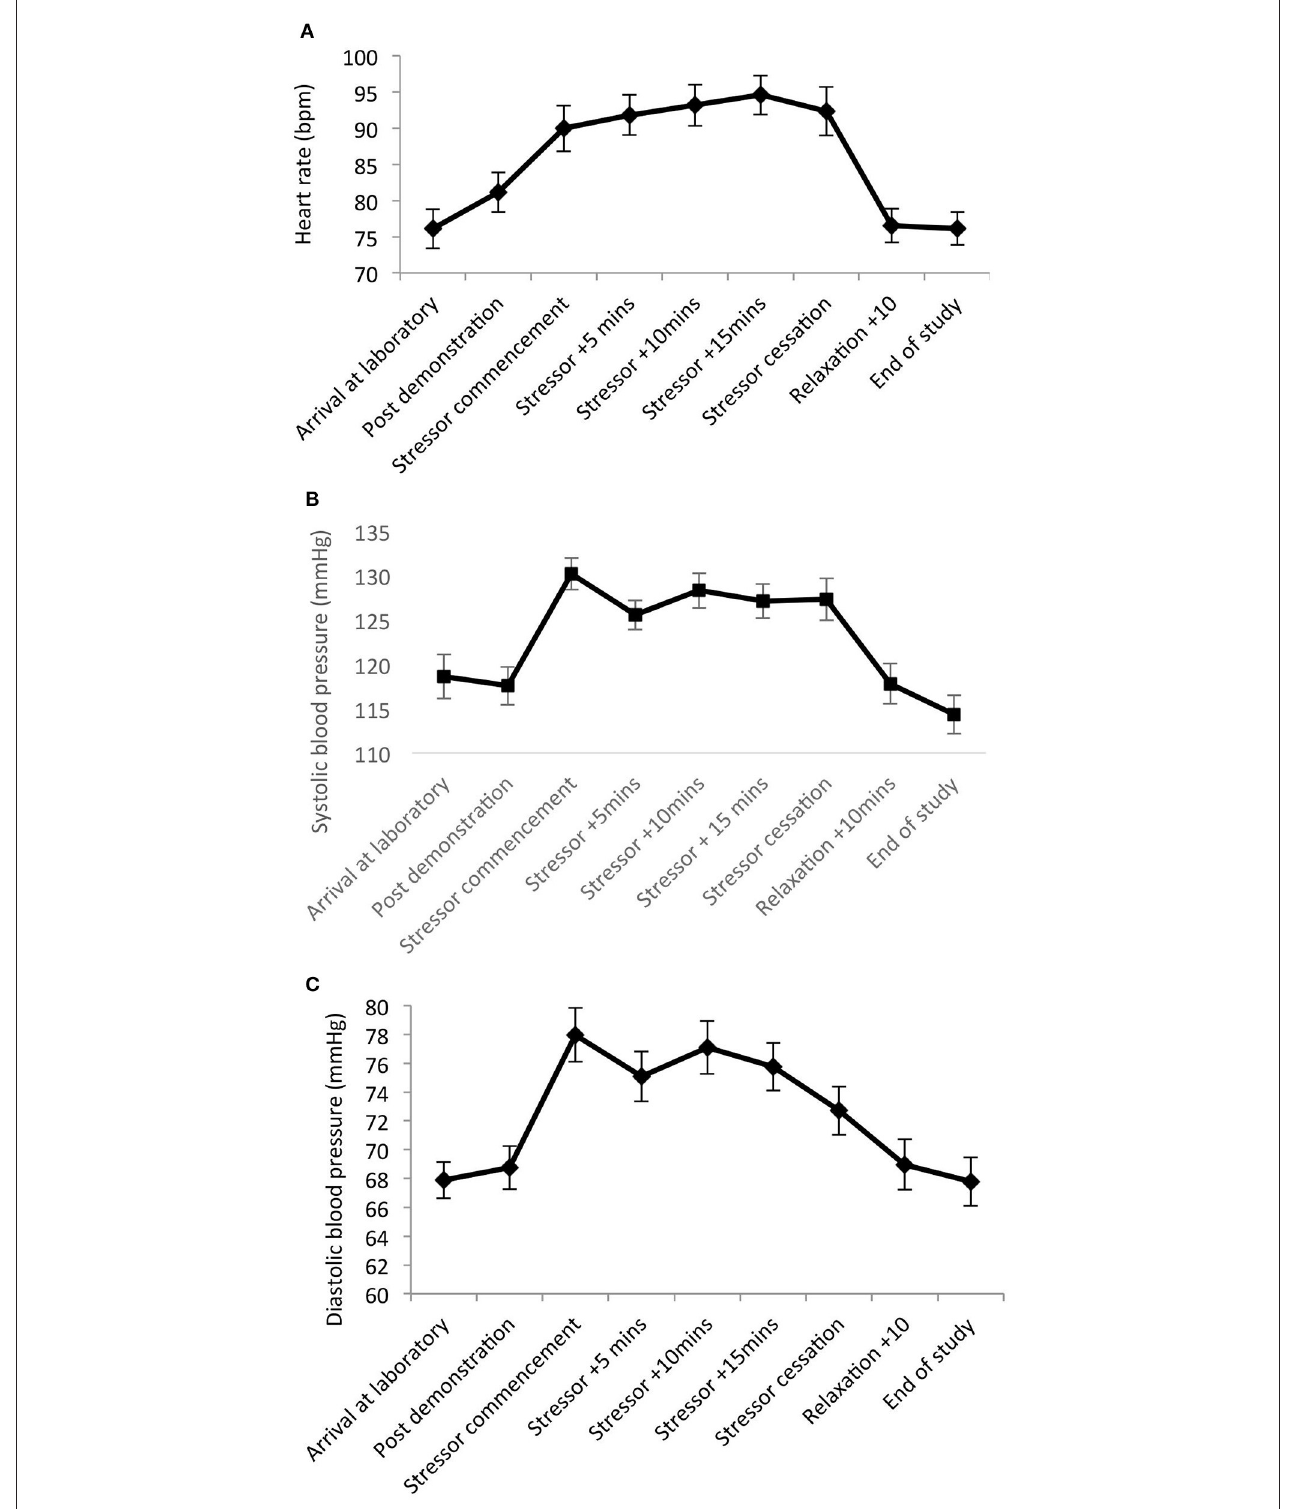
FIGURE 3 | Mean (and SE) heart rate (A) , systolic (B) , and diastolic (C) blood pressure assessed during exposure to the stressor manipulation.